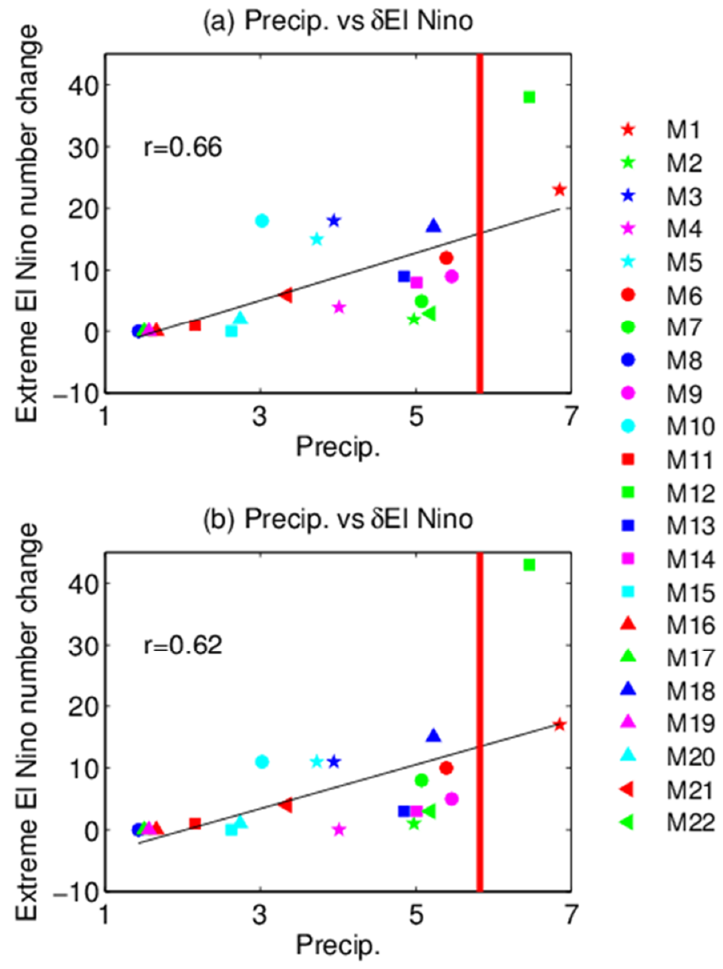
Figure 10. Inter-model relationship between the projected future changes in the number of extreme El Niño occurrences and simulated present-day precipitation (mm/day) over the equatorial western Pacific. The red line for each panel denotes the observed equatorial western Pacific precipitation. An extreme El Niño event in ( a ) was defined when Niño3 DJF precipitation was greater than 5 mm/day. ( b ) Same as ( a ), but an extreme El Niño event was identified when the Niño3 DJF precipitation was over 6